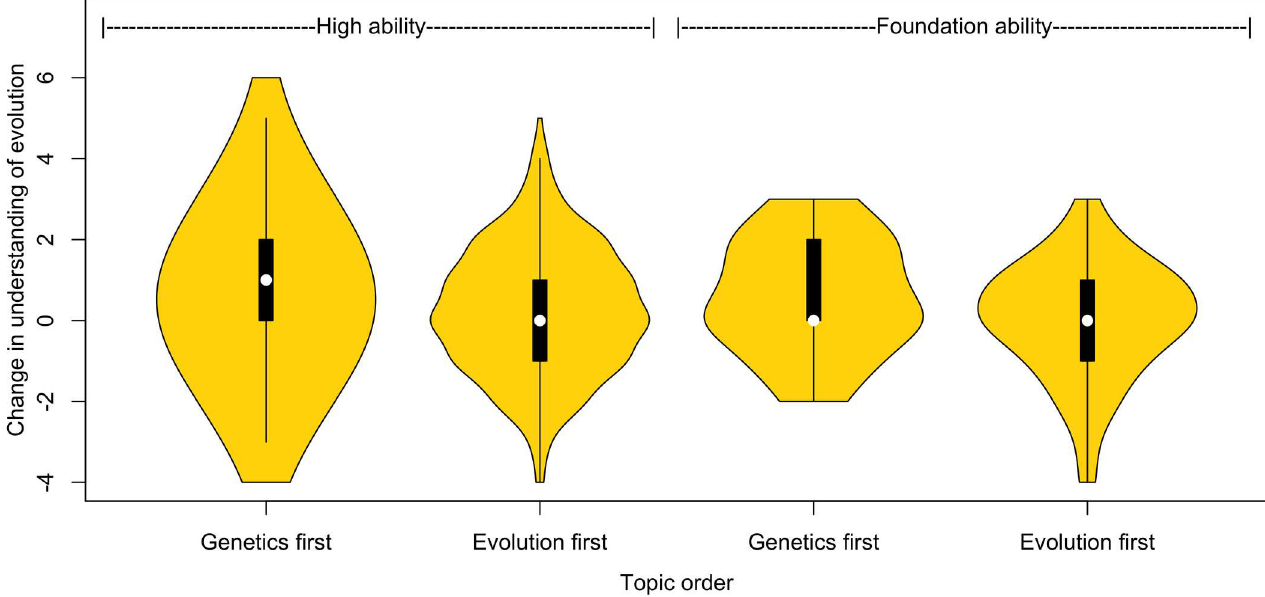
Fig 7. Change in understanding of evolution due to teaching for higher-ability students taught genetics first ( n = 683) and evolution first ( n = 372) and for foundation-ability students taught genetics first ( n = 93) and evolution first ( n = 79). Data plotted here is for the subset of the data in which all students answeredall pre- and postquestionnaires. Raw data can be found in S1 and S2 Data.